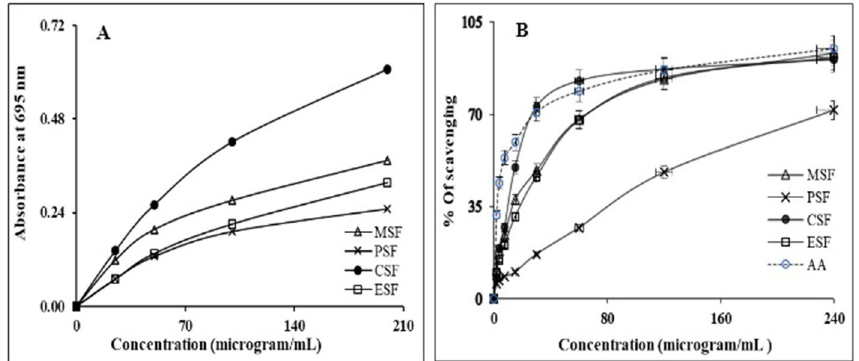
Fig. 1 Evaluation of in-vitro antioxidant activities of the different fractions of C. asiatica . A Total antioxidant capacity; B DPPH free radical scavenging activity. Ascorbic acid (AA) was used as the standard antioxidant. Data was expressed as mean CSF, Chloroform soluble fraction; ESF, Ethyl acetate soluble fraction; MSF, Crude methanol extract